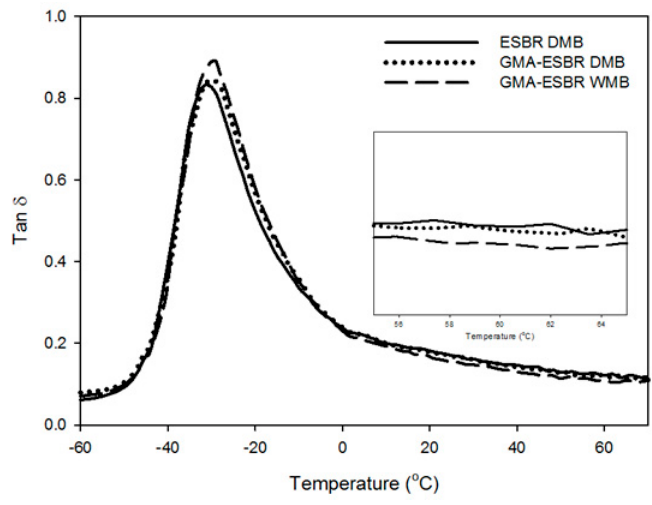
Figure 6. Temperature-dependent tan δ of ESBR DMB, GMA-ESBR DMB, and GMA-ESBR WMB compounds. Table 9. Viscoelastic properties of ESBR DMB, GMA-ESBR DMB, and GMA-ESBR WMB compounds. Sample